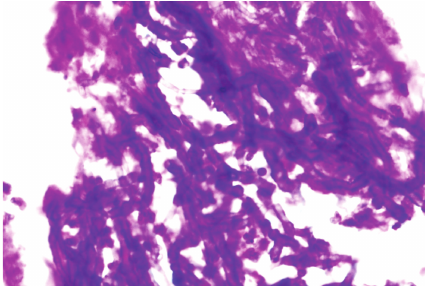
Figure5:Hematoxylinandeosin( × 400magnification)HPEpicture showing tufts of fungal hyphae.